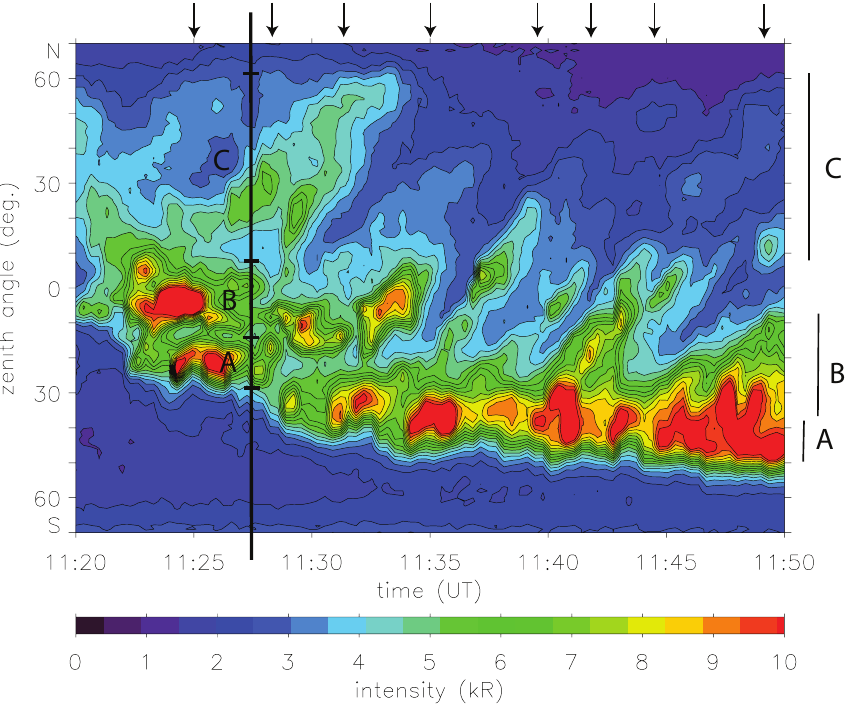
Fig. 2. MSP observations at 630.0 nm for the interval 11:20–11:50 UT as obtained from Ny ˚Alesund (76 ◦ MLAT). Line-of-sight intensities (along the magnetic meridian) as a function of zenith angle and time are shown in a colour coded contour plot. The intensity scale is given at the bottom. North is up. Three latitudinally separate forms are marked A, B, and C. The MSP FOV at 630.0nm is indicated by the double-arrowed meridinal line in Fig.